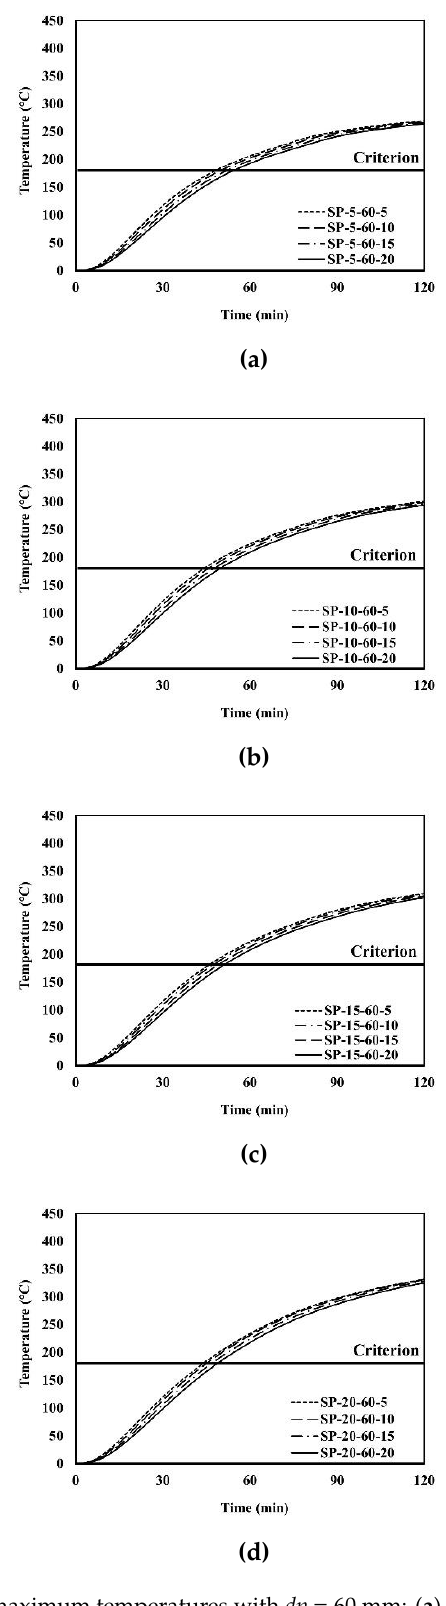
Figure 17. Time history of maximum temperatures with dp = 60 mm: ( a ) SP-5-60-x; ( b ) SP-60-20-x; ( c ) SP-15-60-x; ( d ) SP-20- 60-x.